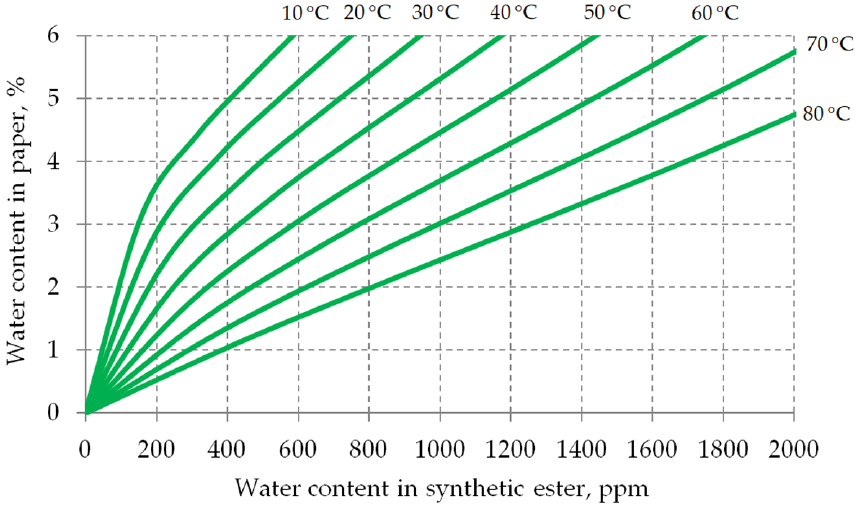
Figure 8. Moisture equilibrium curves for cellulose paper and synthetic ester Midel 7131.